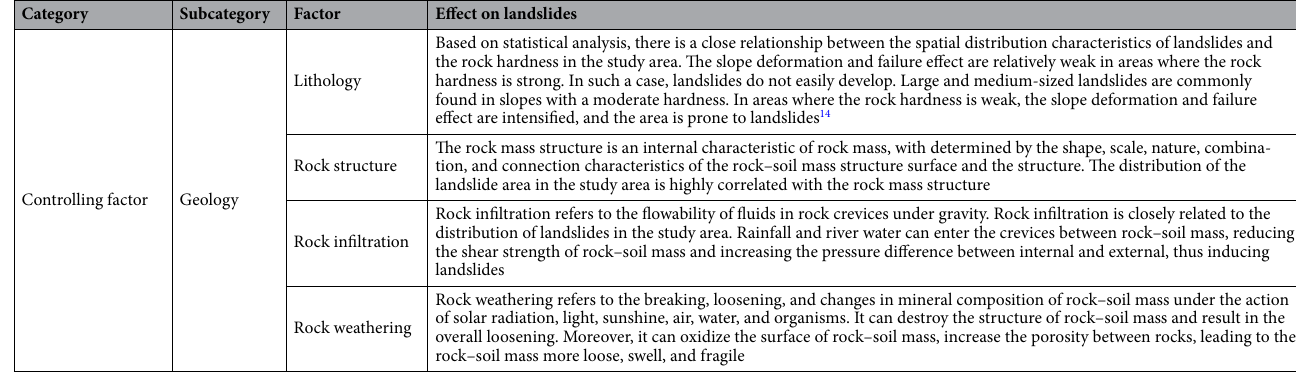
Table 4. Rock–soil characteristic factors and effect on landslides.